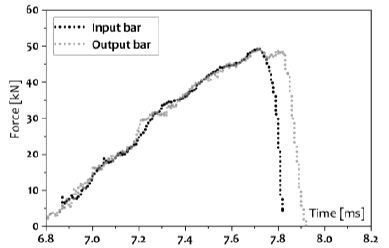
Fig. 3. Force equilibrium input and output bar for the experiment at 16.5